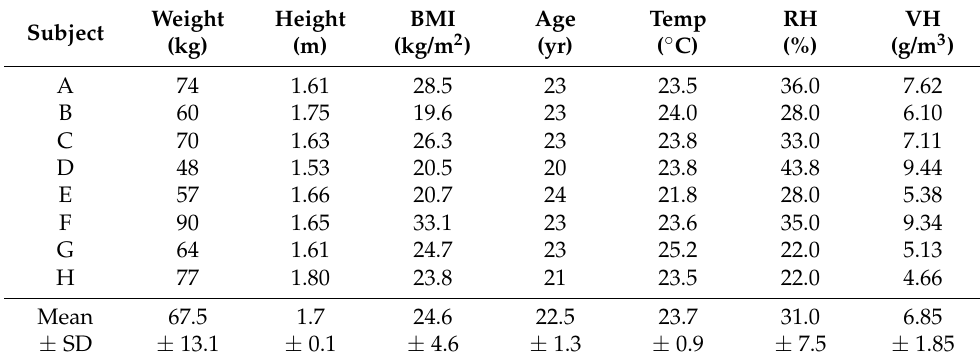
Table 1. Subject information and experimental conditions.